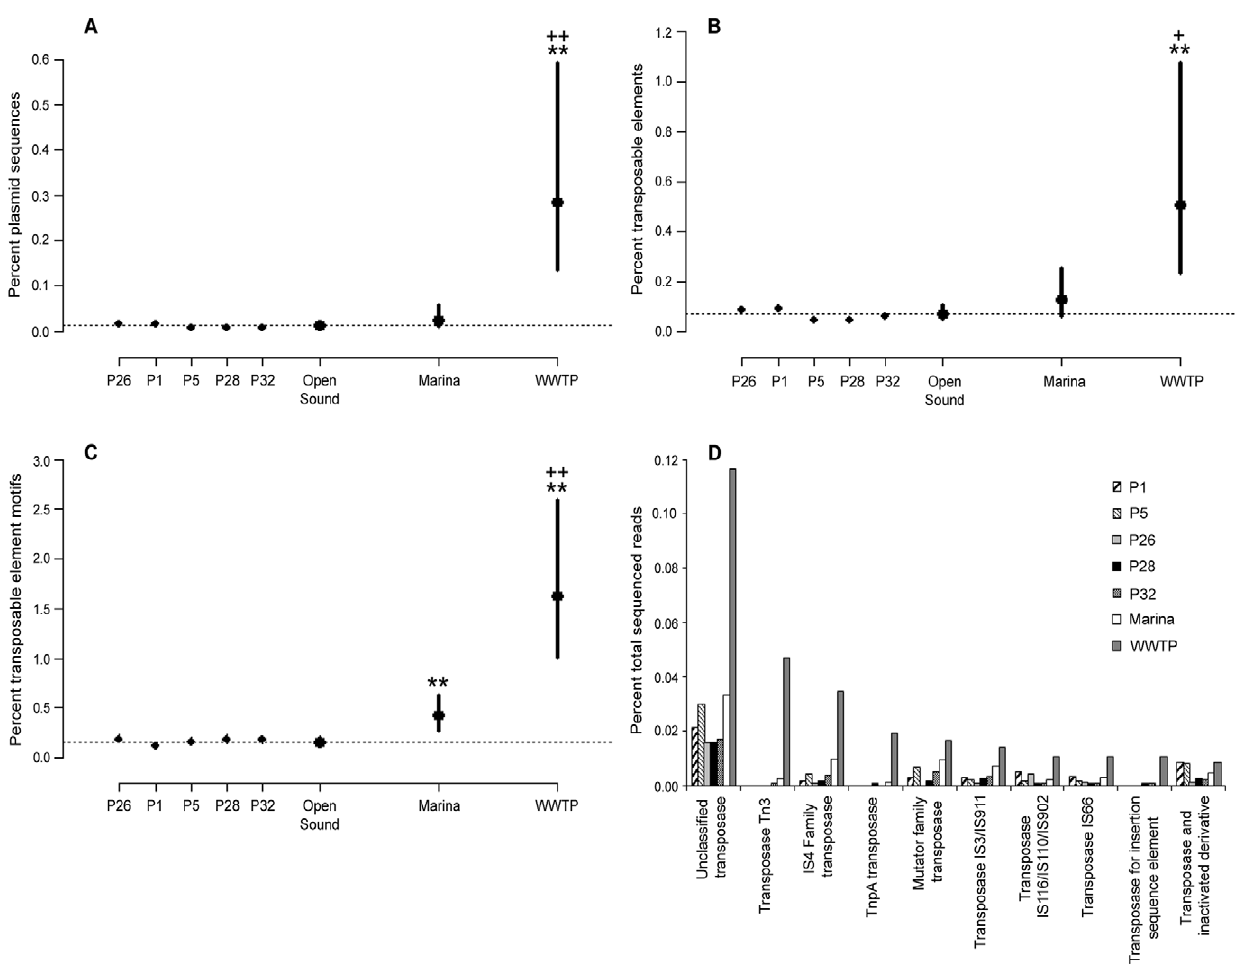
Figure 6. Prevalence of mobile genetic elements in the Puget Sound metagenomes. (A) Plasmid sequences, (B) transposable elements using a BLAST search against GenBank, (C) transposable elements using a hidden markov model (HMM) search against the Pfam database and (D) top ten most abundant transposable elements from the WWTP effluent by percent abundance. Bars represent 95% confidence intervals for binomial proportions. P-values are relative to the open Sound and are corrected for multiple testing. For open Sound vs. Marina and WWTP, *p , 0.05 and **p , 0.005. For Marina vs. WWTP, + p , 0.05 and ++ p , 0.005. Bars represent 95% confidence intervals for binomial proportions. The dashed line represents the mean percent for the open Sound. Similar profiles for mobile genetic elements were seen for the open Sound samples while significant differences emerged when comparing to the Marina and effluent.